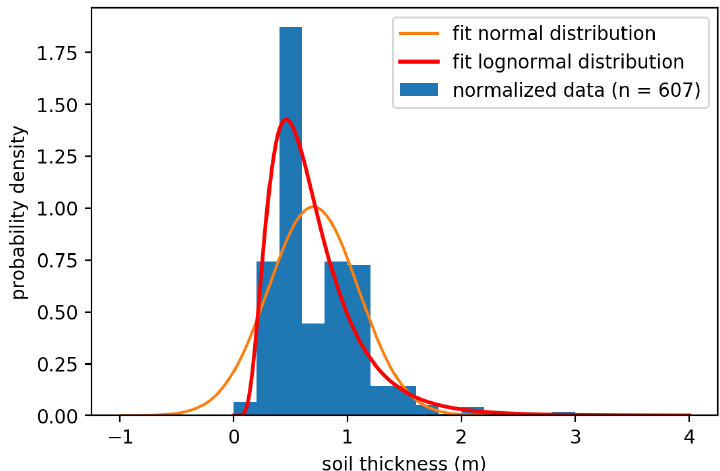
Figure A1. Plot of the probability density of the soil thickness data from the BAFU dataset as used in this paper. The best fit is given of a normal and a log-normal distribution. The mean square errors are 0.096 and 0.053 for the normal and log-normal fit respectively.